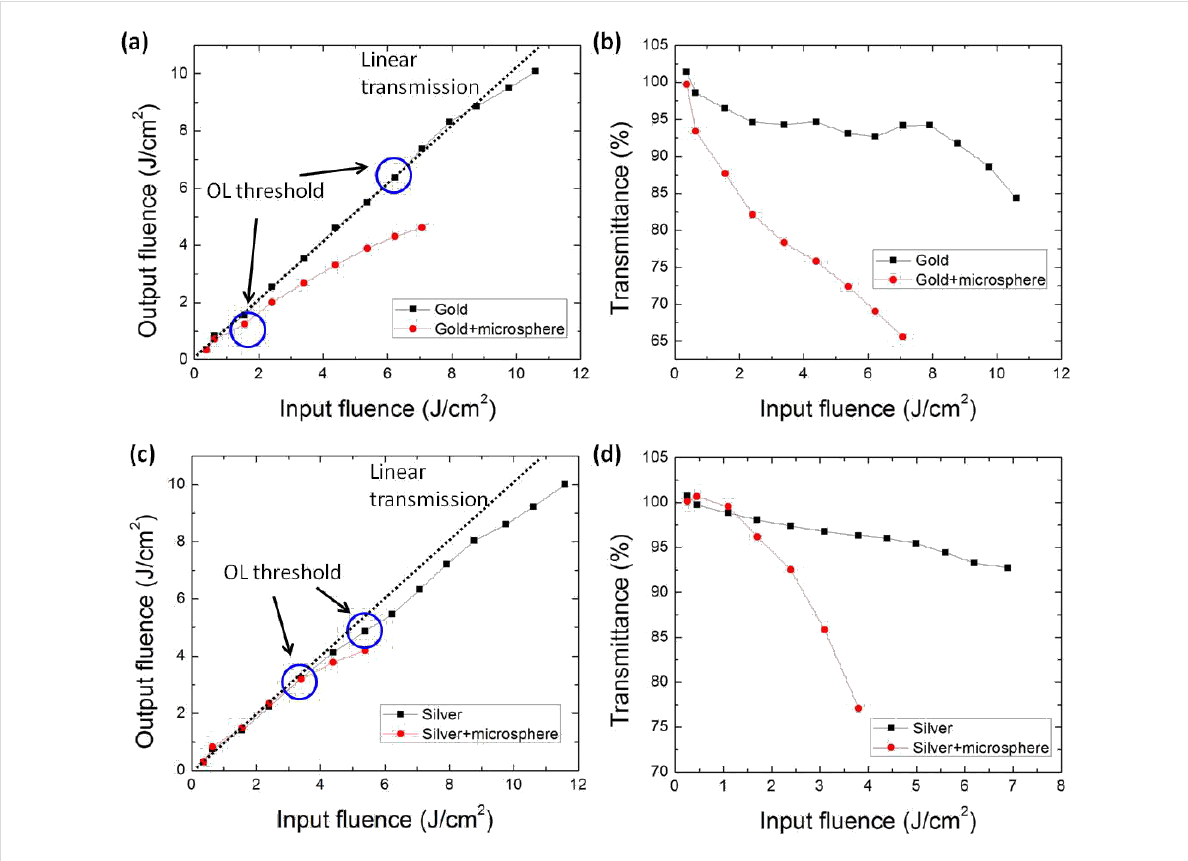
Figure 3: Optical limiting (OL) response and normalized transmittance curves of (a,b) gold nanoparticles and gold/silica nanocomposites and (c,d) silver nanoparticles and silver/silica nanocomposites.